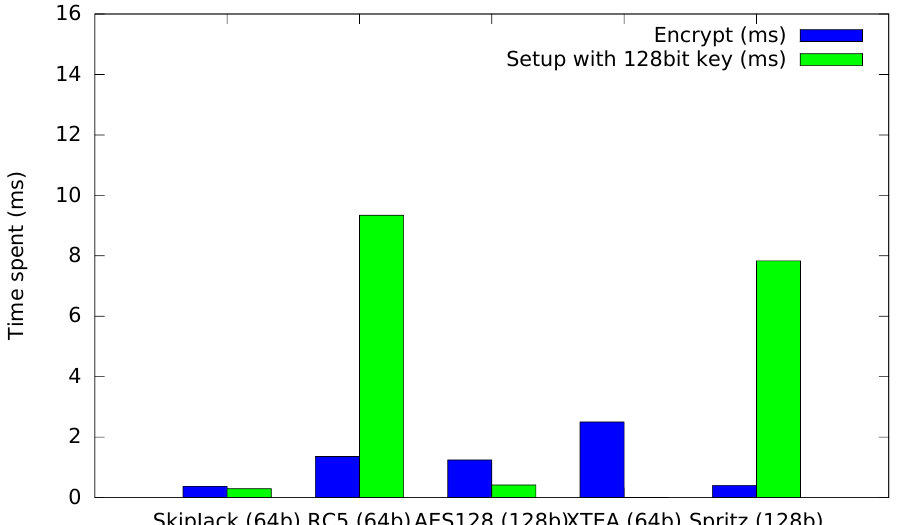
Figure 5. Time required for cipher setup (128-bit key) and